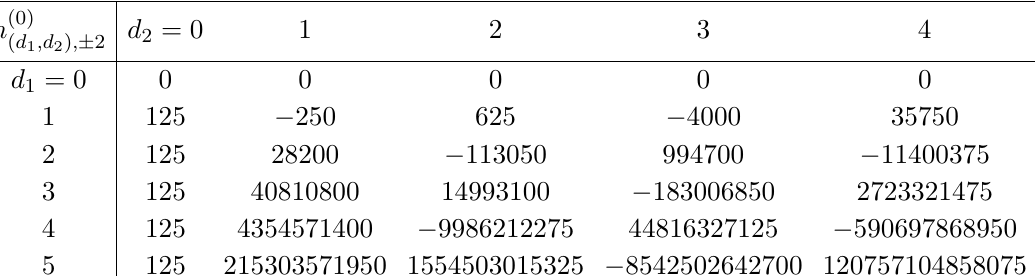
with Z charge ± 2 . 5 0